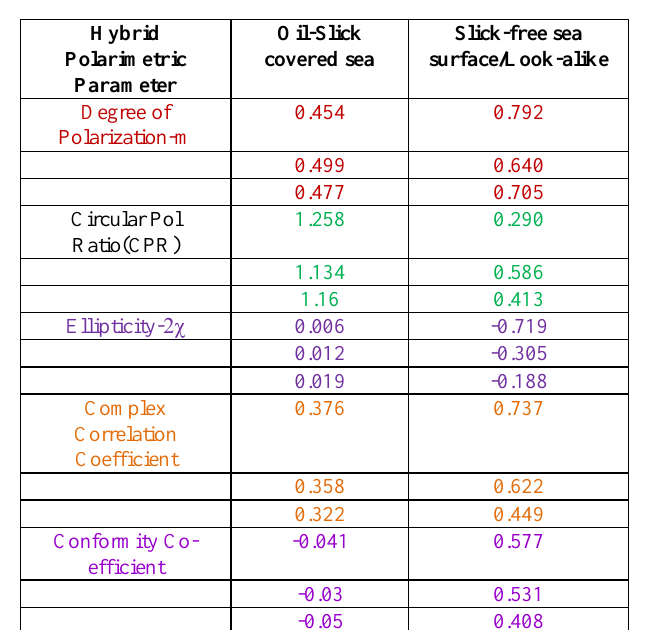
Figure 3: RISAT-1 CTLR hybrid Pol data with oilslick Date of Imaging: 17-June 2014 Orbit: 11810/11805 Mode: cFRS-1 Incidence Angle: 49.4 deg